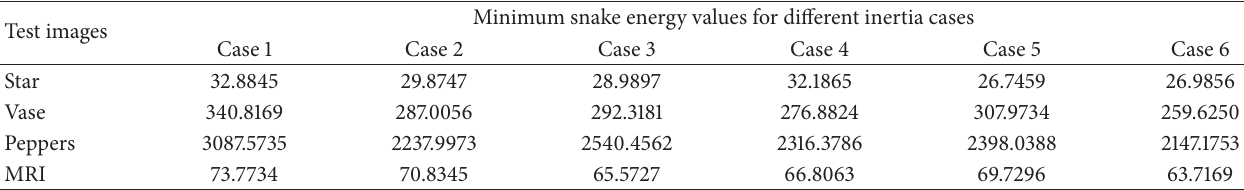
Table 2: Minimum snake energy values obtained by “multipopulation PSO” method for different cases of inertia.